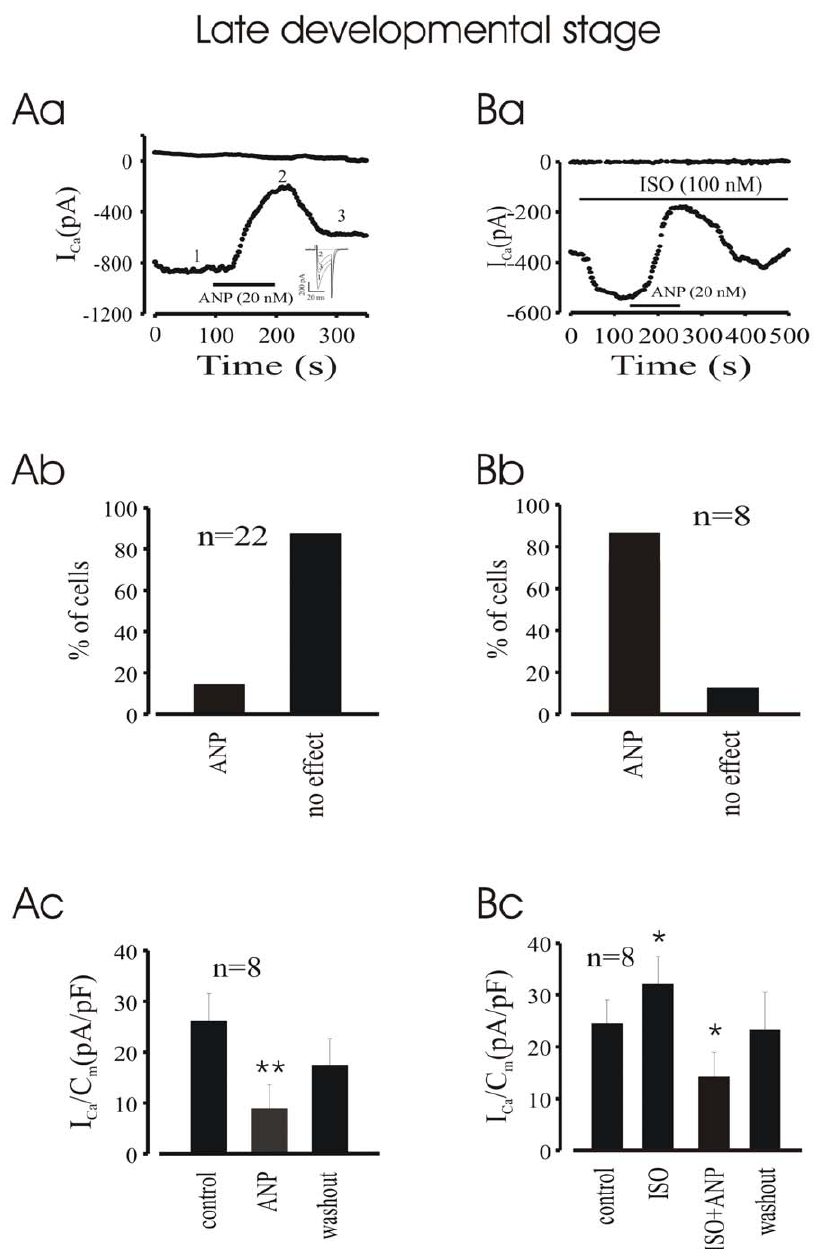
Figure 4. Effect of ANP on basal and ISO stimulated I CaL in LDS cells. Aa & Ba , time courses of peak I CaL recorded from single LDS cells. Both basal and ISO pre-stimulated I CaL were strongly depressed by application of ANP. Ab & Bb , percentage of cells responding to ANP. Note that the percentage of responding cell in EDS is much lower compared to LDS cells. Ac & Bc , current density of peak I CaL . *P , 0.05, **P , 0.01 compared with control,